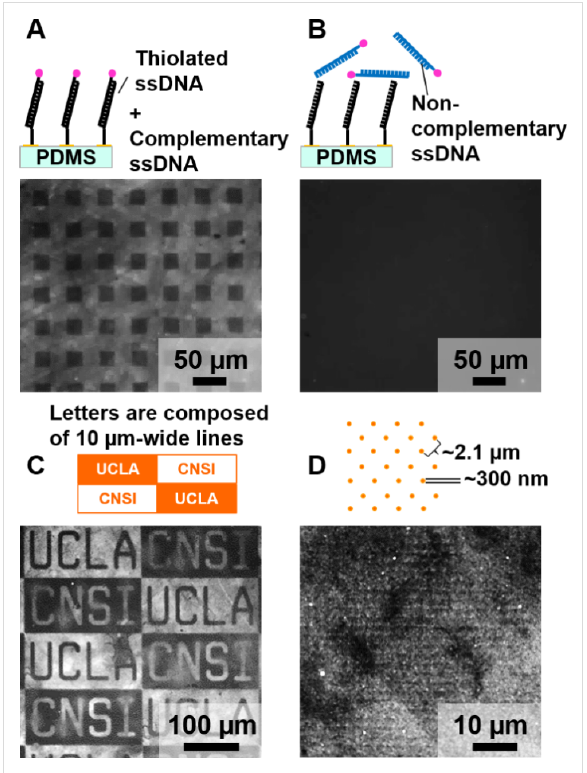
Figure 2: Fluorescence visualization of patterned lifted-off Au–alkane- thiolate monolayers via DNA self-assembly and hybridization. (A) (Top) Scheme for complementary DNA hybridization experiments. (Bottom) Fluorescence microscopy image of a Au–alkanethiolate monolayer pattern on flat poly(dimethylsiloxane) (PDMS) after incubation with thiolated single-stranded DNA. Bright (lifted-off) regions between squares are indicative of hybridization of AlexaFluor ® 488-labeled complementary DNA. Square regions are dark due to the absence of Au, and therefore, also the absence of self-assembled DNA neces- sary for hybridization. (B) (Top) Scheme for noncomplementary control experiments. (Bottom) Similar substrate and DNA self-assembly as in panel A with the exception that scrambled, noncomplementary, fluo- rescently labeled DNA was used for hybridization. (C) Flat PDMS was patterned with Au–alkanethiolate monolayers in the “CNSI” lettered and “UCLA” relief regions. The patterns were then visualized using the same DNA self-assembly and hybridization procedure as in panel A. (D) A different region of the same PDMS sample shown in panel C but patterned with 300 nm dots having a nearest-neighbor center-to-center separation of 2.1